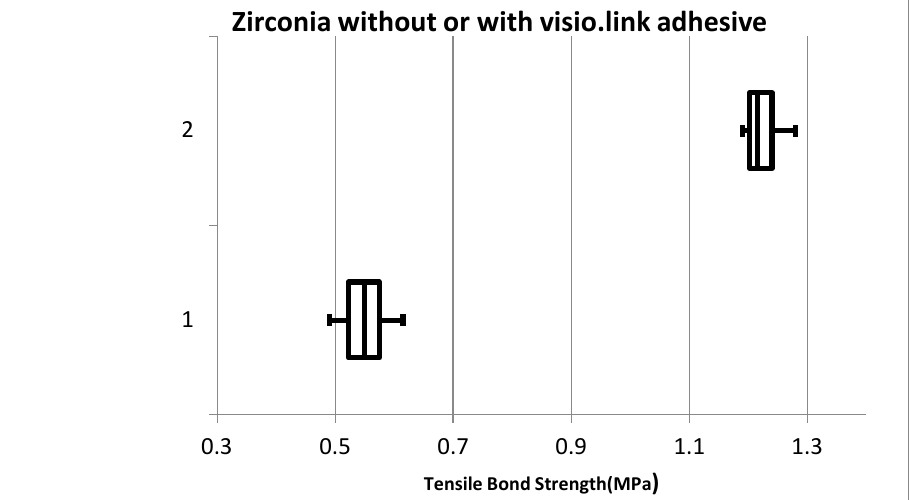
Figure 9. Comparison of mean tensile bond strength of Zirconia with and without visio.link adhe- sive.Vertical Axis:1—Zirconia without Visio.link adhesive, 2—Zirconia with Visio.link adhesive.